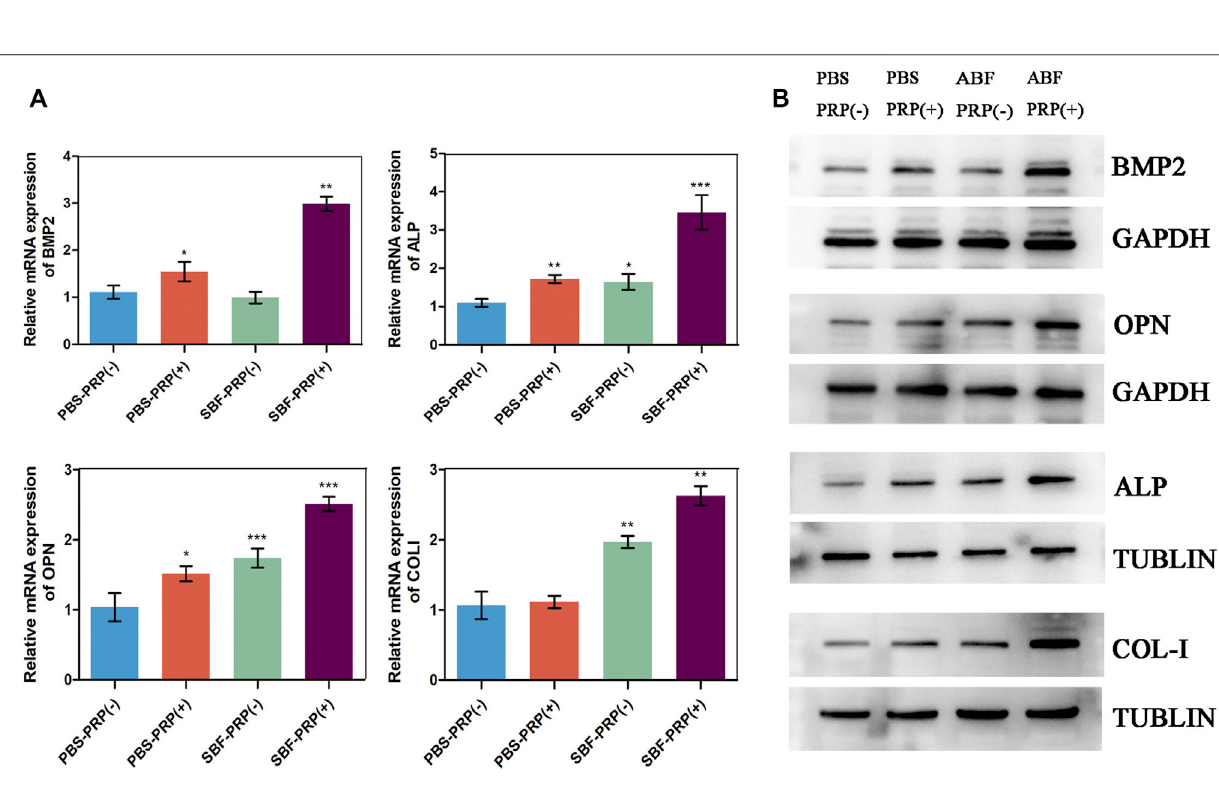
Frontiers in Bioengineering and Biotechnology |